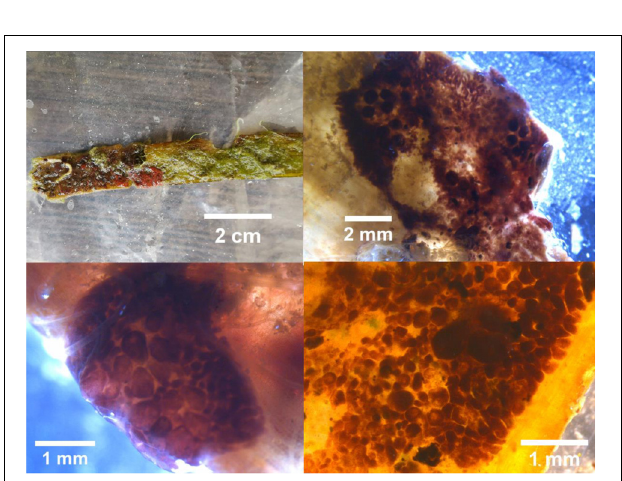
FIGURE 4 | Botrylloides nigrum attaching on the leaf of Enhalus acoroides with different scales collected from Xincun Bay, Hainan Island.